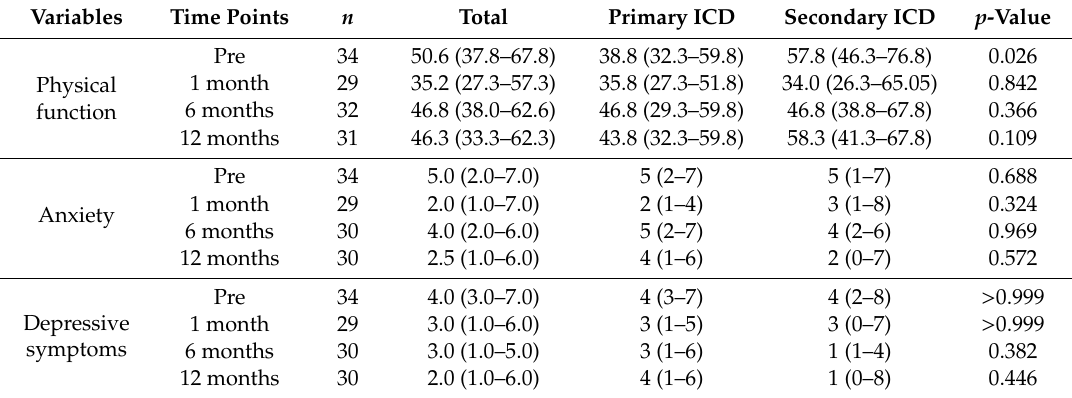
Table 2. Pre-Implant and 1, 6, and 12 months Post-Implant Physical and Psychological Dysfunction Scores in Primary versus Secondary ICD